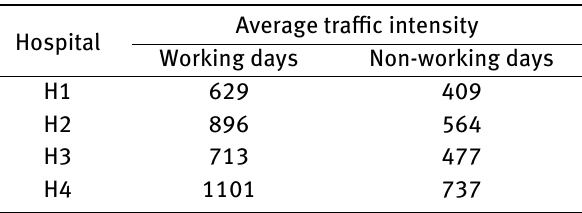
Table 1: Average values of traflc intensity for the four hospitals on working and non-working days